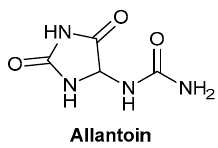
Figure 5. Chemical structure of allantoin, one of the major components responsible for the pharmacological effects of Symphytum × uplandicum Nyman.